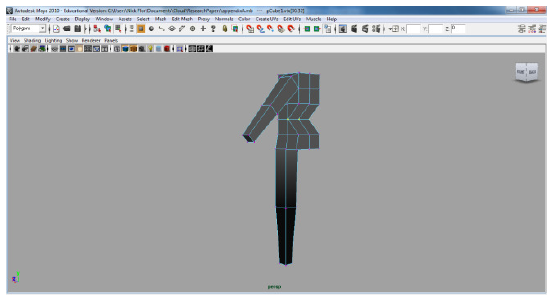
Figure 16. The Fourth Row of Back Vertices Moved Absolute to Z=0, to Create a Back